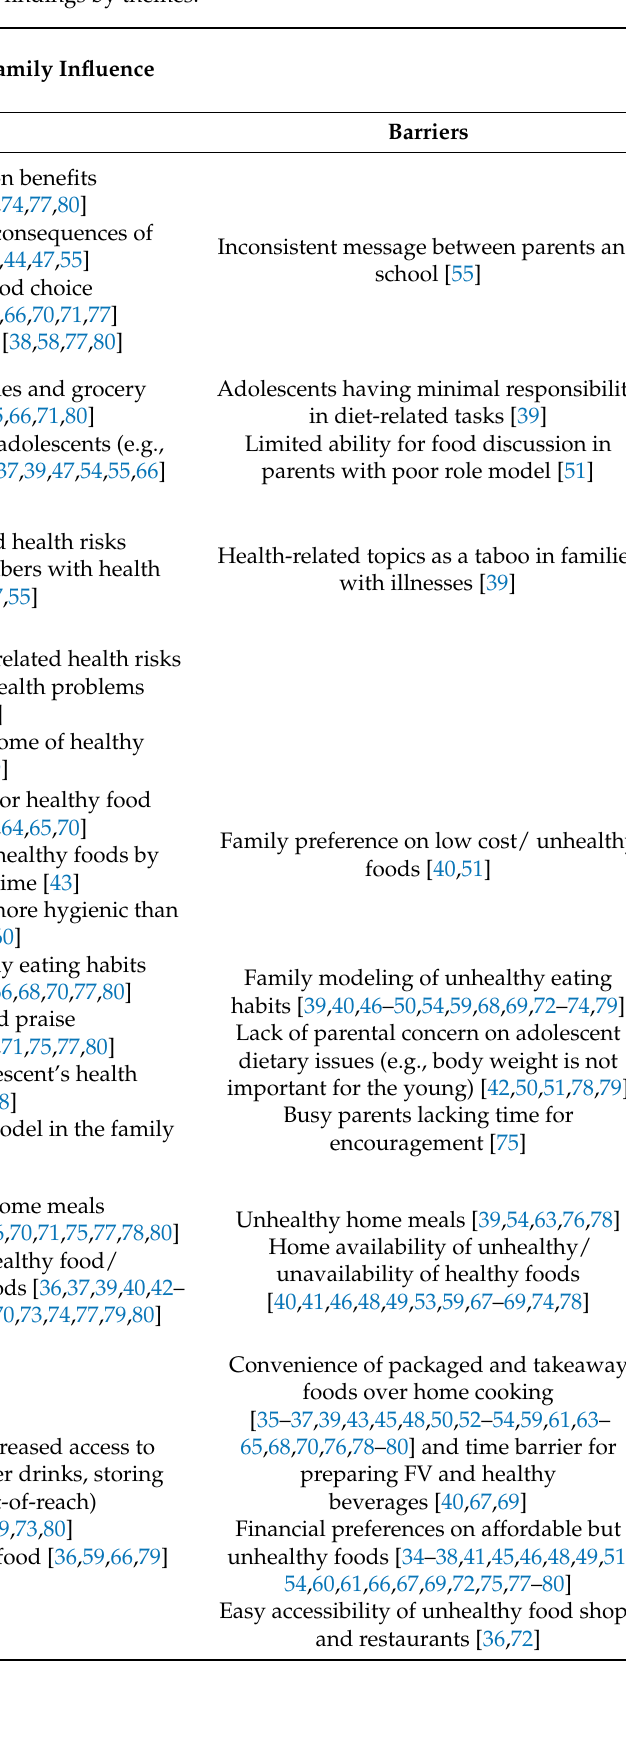
Table 4. Summary of findings by